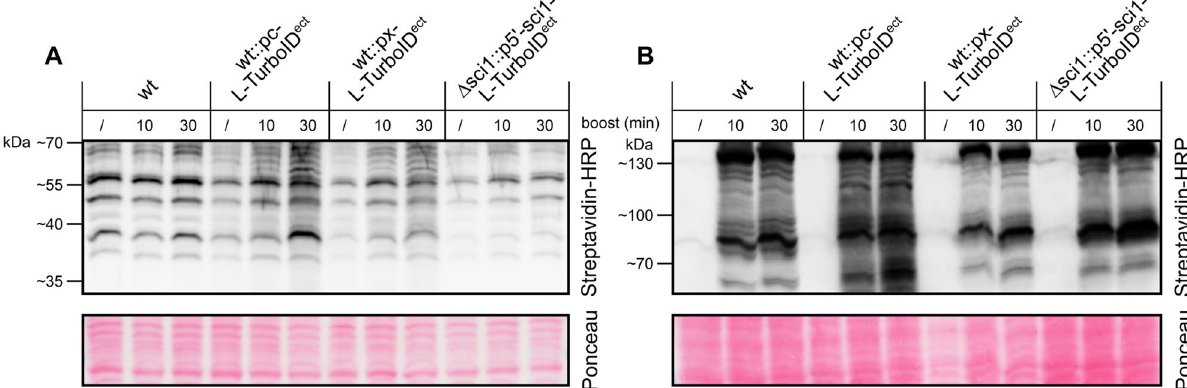
Figure 3. Western blot analysis of TurboID activity in recombinant S. macrospora strains. The activity of free TurboID and SCI1-TurboID fusion proteins in S. macrospora was determined by Western blot-like hybridization using Streptavidin-HRP. Streptavidin binds biotinylated proteins, and HRP is used for signal detection via chemiluminescence. Expression of the constructs is controlled by either the ccg1 overexpression promoter from N. crassa (pc), the native sci1 promoter (p5’), or the xylose inducible Smxyl promoter (px) 19 . Untransformed wt shows endogenous biotinylation of S. macrospora . 2.25 µL crude protein extract were loaded onto the gel. Ponceau red staining was used as loading control. A) Strains were grown in liquid BMM medium for 3 days at 27 °C. Before harvest, BMM supplemented with biotin was added (final concentration = 410 nM) for 10 or 30 min. B) Strains were grown in liquid SWG medium (1 g/L arginine, without biotin) for 5 days at 27 °C. Shortly before harvest, SWG supplemented with biotin was added (final concentration = 410 nM) for 10 or 30 min. Blots and Ponceau red staining in ( A,B ) show the identical membrane, exposure was identical for all parts of the gel. Figure shows cropped blots. Full length blots and Ponceau red staining are depicted in Supplementary Fig. S6. ect, ect opically